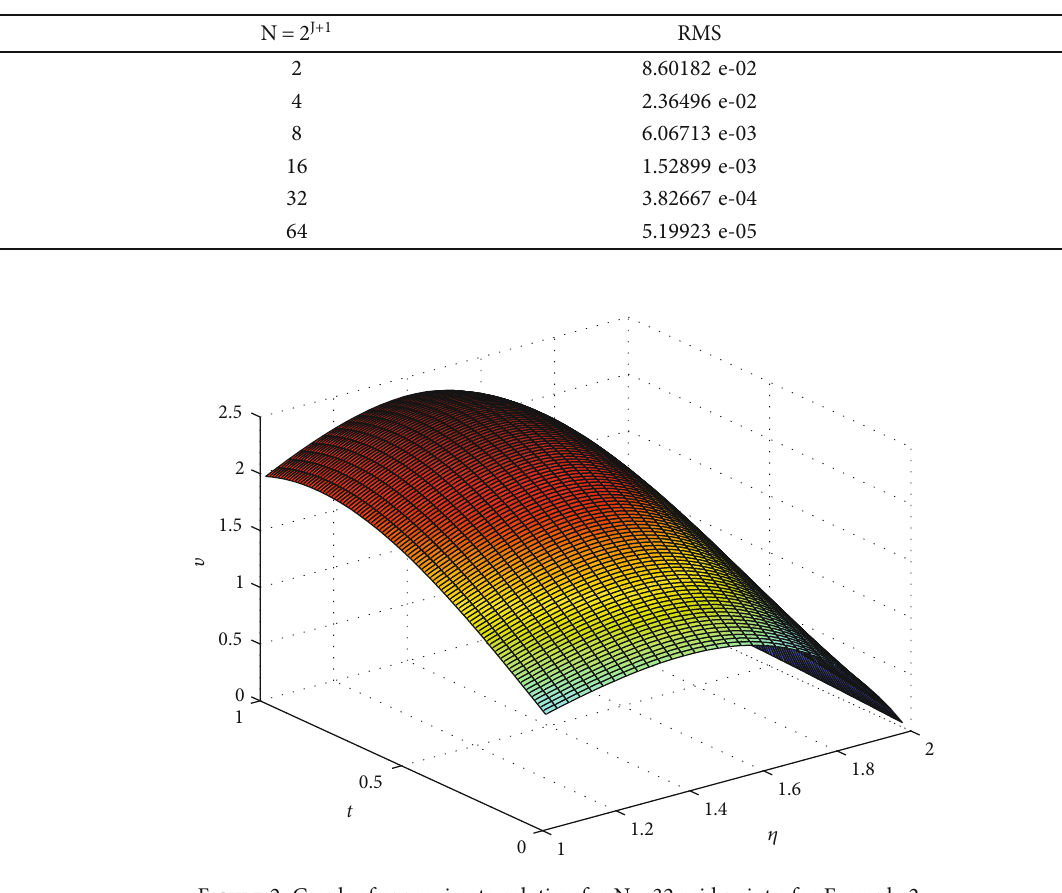
Figure 1: Graph of approximate solution for N = 32 , grid points for Example Table 2: RMS and E ð N Þ errors for Example 2.